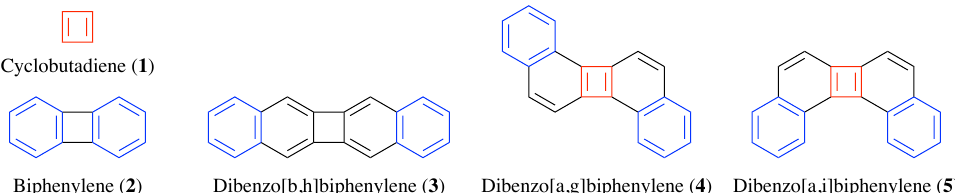
Figure 2. Chemical structures of the molecules considered within this work. Clar sextets are highlighted in blue, Baird quartets in